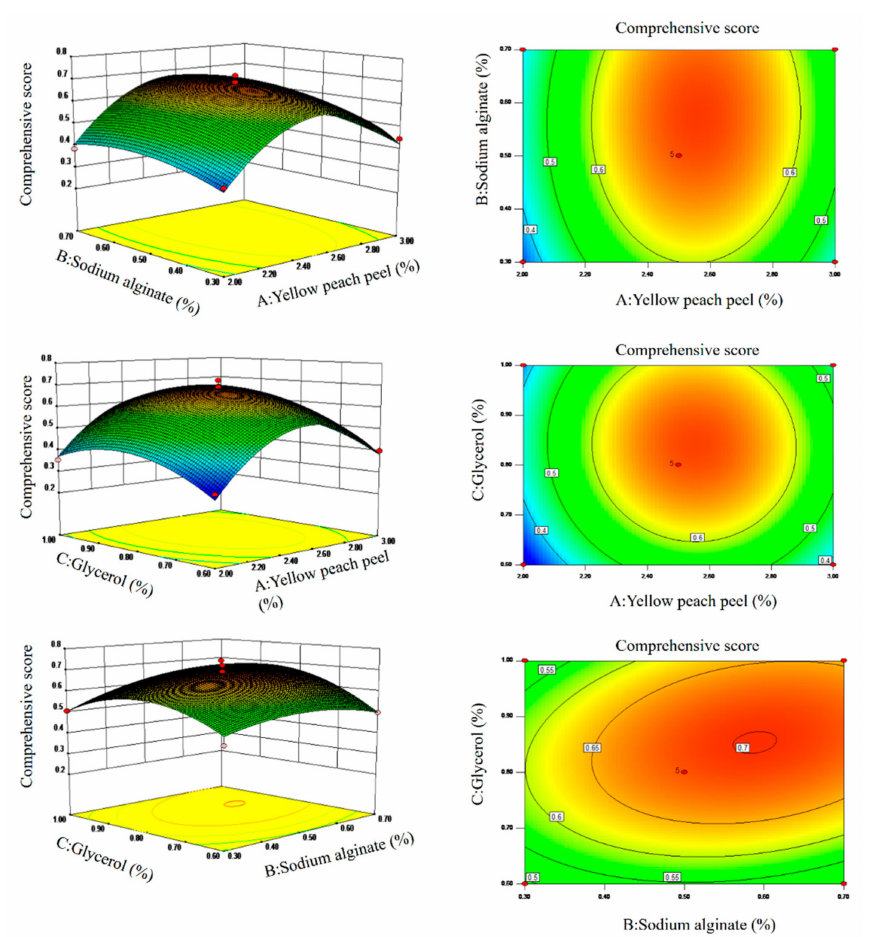
Figure 2. Response surface of environmental factors; Response face and Contour map between